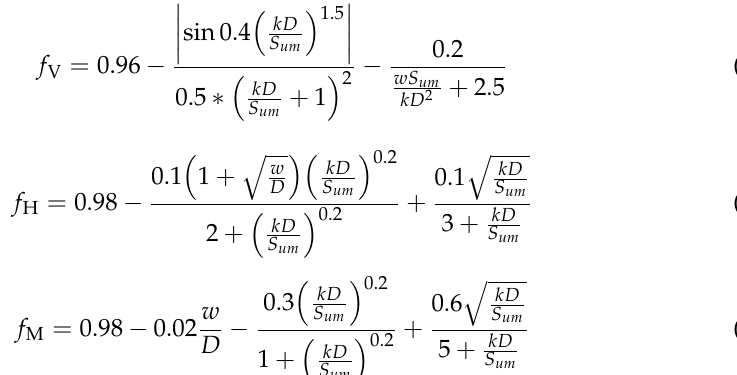
and D on f M when w D s S um